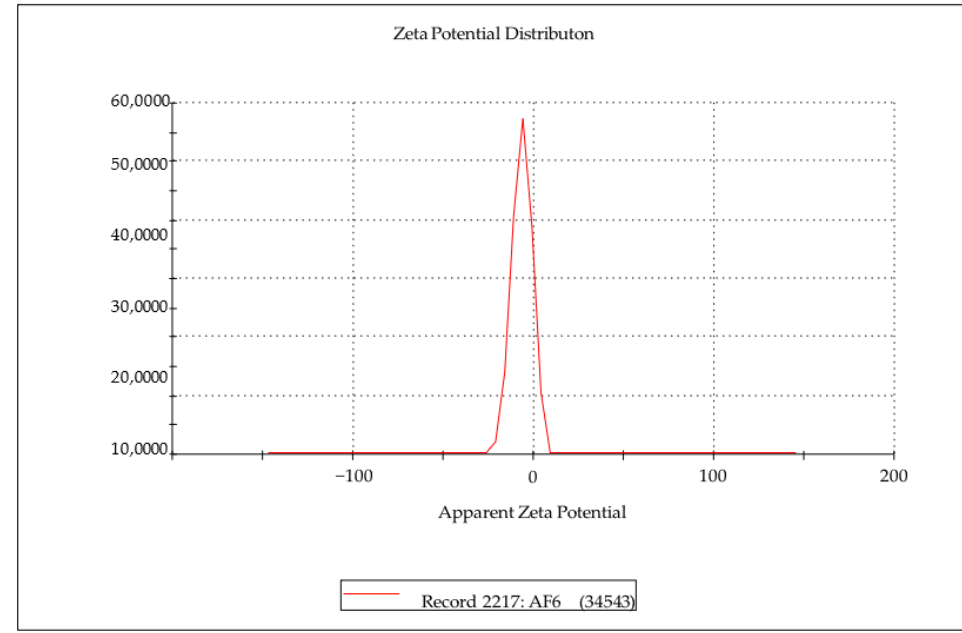
Figure 4. Zeta potential distribution curve of AF6.